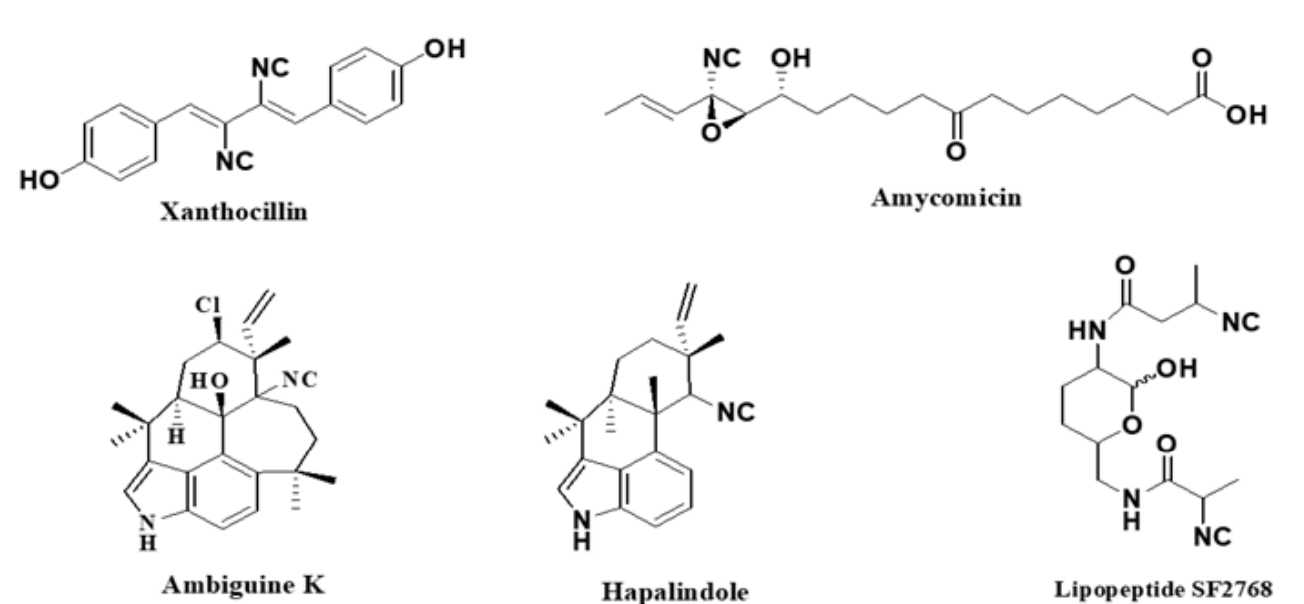
Figure 1. Examples of natural products bearing one or two isocyano functional groups.